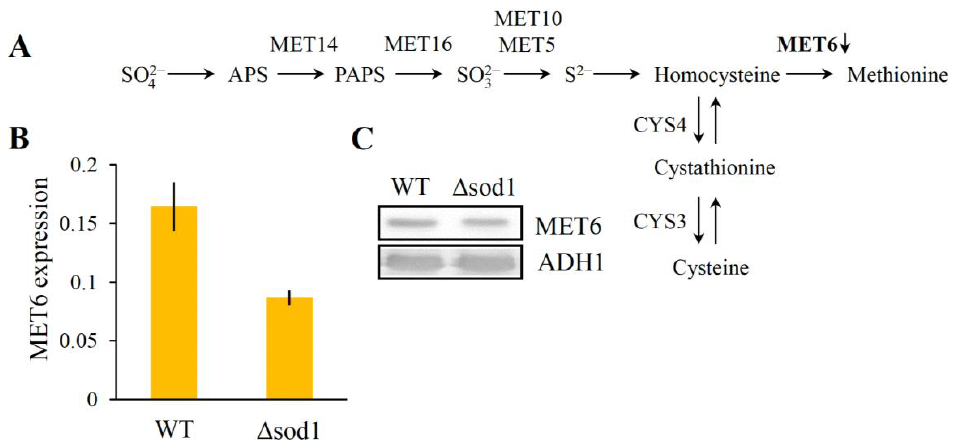
of sulfur amino acids. APS—5 (cid:48) -adenylylsulfate; PAPS—3 (cid:48) -phospho-5 (cid:48) -adenylylsulfate; MET14—APS kinase; MET16—PAPS reductase; MET10— α -subunit of sulfite reductase complex; MET5— β -subunit of sulfite reductase; CYS4—cystathionine β -synthase; CYS3—cystathionine γ -lyase; downward arrow indicates protein downregulation in the ∆ sod1 mutant compared to the WT strain. ( B ) The expression of the MET6 gene and ( C ) the content of MET6 protein in the WT strain and the ∆ sod1